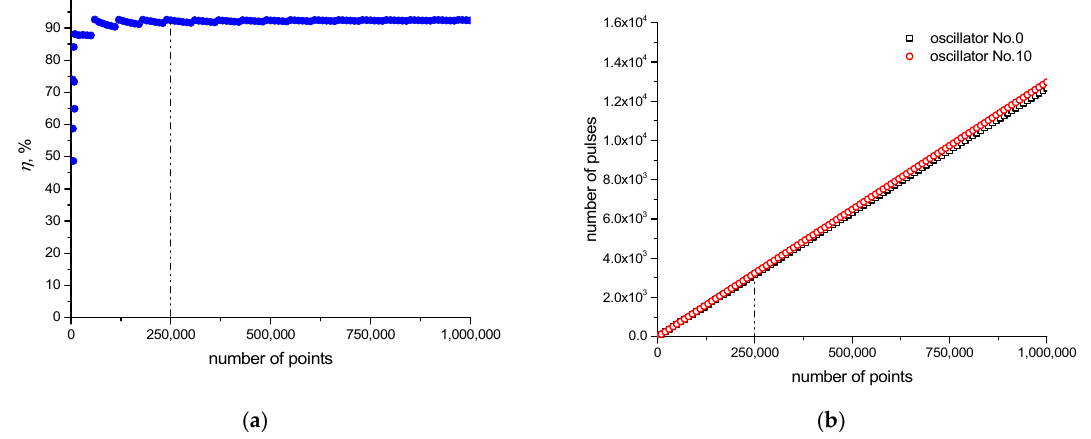
Figure A4. Spectrum of a current signal for the oscillogram shown in Figure A3.